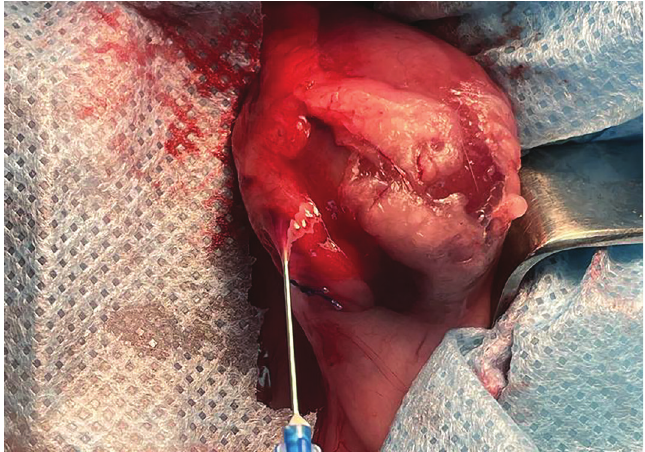
Figure 3 - Urine sampling from the renal pelvis.